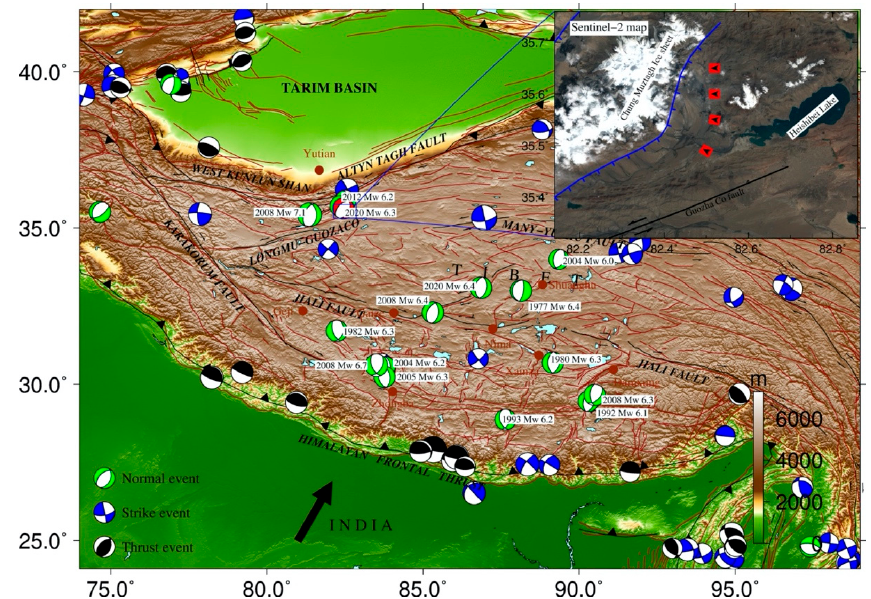
Figure 2. Seismicity in Tibet and local geomorphic features (after [11]). Beach balls represent focal mechanism solutions of events with magnitude larger than Mw 6 during 1976–2020 from GCMT, in which normal, strike, and thrust events are rendered in green, blue, and black, respectively. The normal Yutian event in 2020 is plotted with red. The insert map shows near field geomorphic features for this event from the Sentinel-2 optical image. Red symbols with black triangles show locations of gullies .